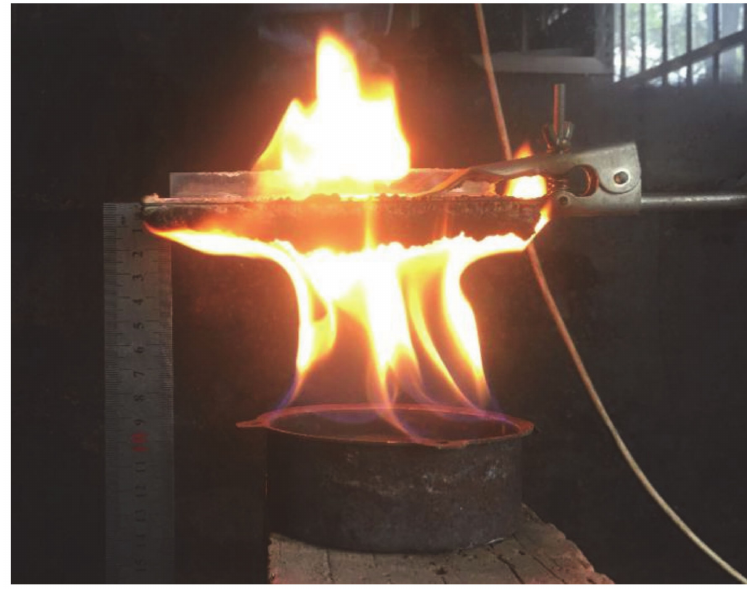
Figure 15. Supplementary experiment.